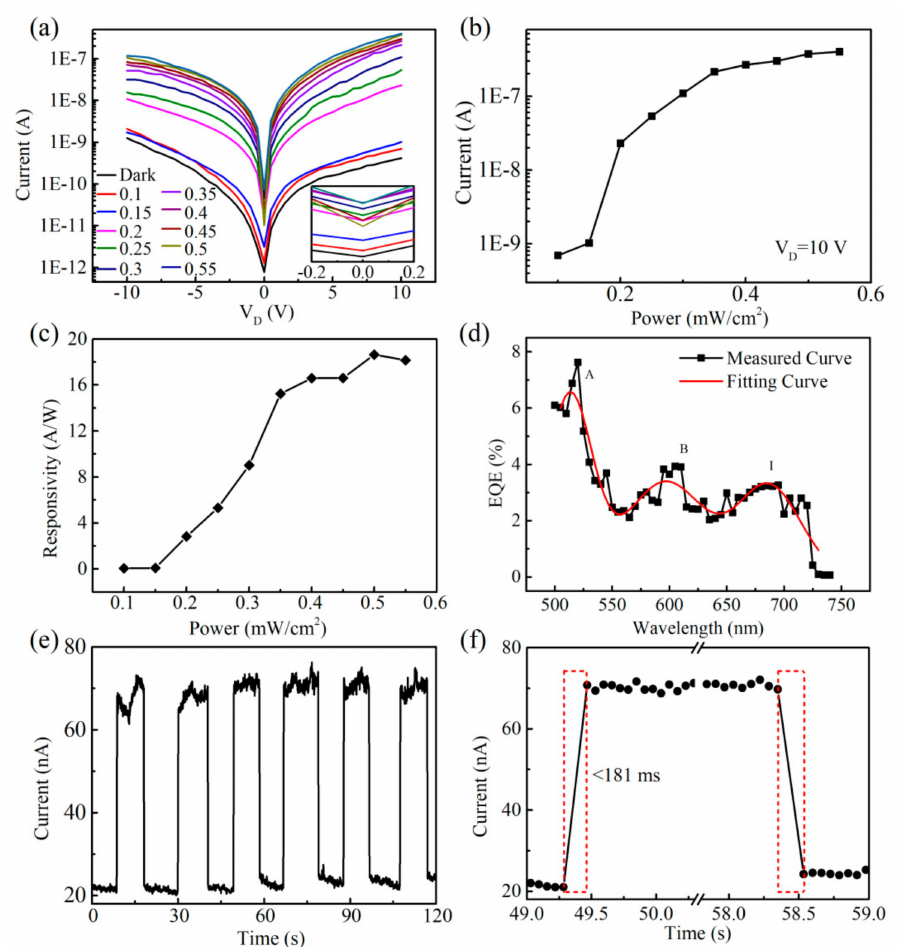
Figure 6. ( a ) The photocurrent versus applied V D sweeping from − 10 V to 10 V ( V G = 0 V) at di ff erent light intensities. The inset shows the detailed I – V characteristics in the 0 V region. ( b ) The dependence of the photocurrent ( I D , light ) (in (a)) on the laser intensity (mW / cm 2 ) ( V G = 0 V, V D = 10 V). ( c ) Power intensity dependence of the responsivity ( V G = 0 V, V D = 10 V). ( d ) Spectral dependence of the EQE using a 100-ps pulse laser ( V G = 0 V, V D = 10 V). ( e ) Photoresponse in the dark and under 450-nm laser irradiation with a light intensity of 0.14 mW / cm 2 ( V G = 0 V, V D = 10 V). ( f ) Rise and decay time of the photodetector ( V G = 0 V, V D = 10